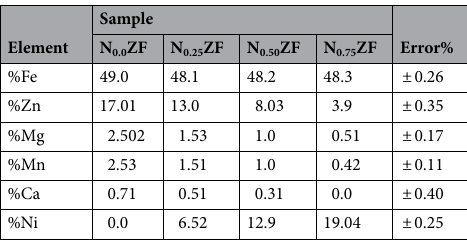
Table 4. Chemical analysis of the prepared NZF samples.